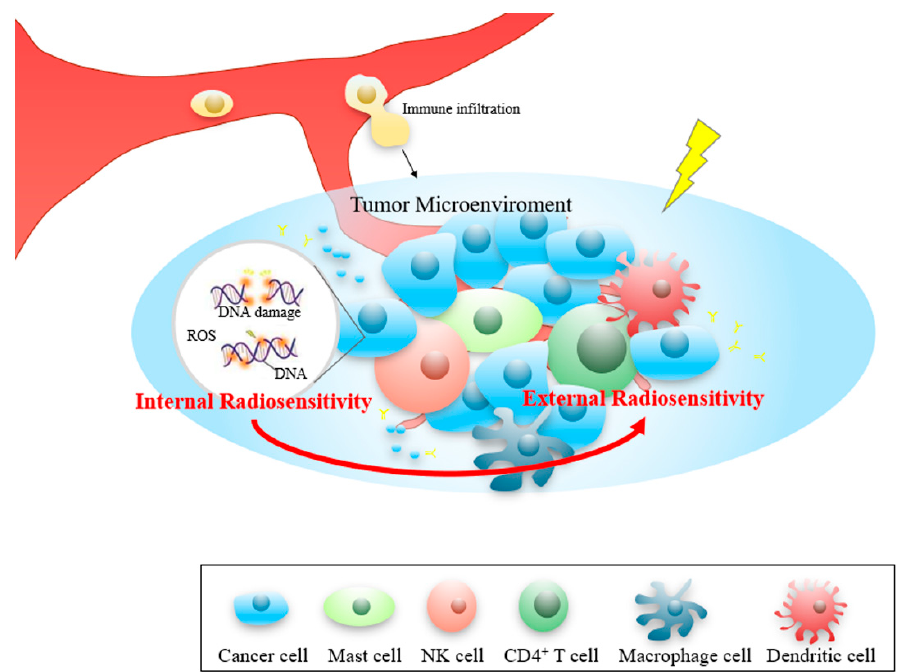
the TCGA data, Table S2: Detailed information for the 7 cancers., Table S3: Description of the 3 predictable genes, Table S4: Univariable and multivariable cox regression analysis of 3-gene signature, Figure S1–S7: Correlation matrix for 7 cancer types, Figure S8: DEGs between high immune level group and low immune